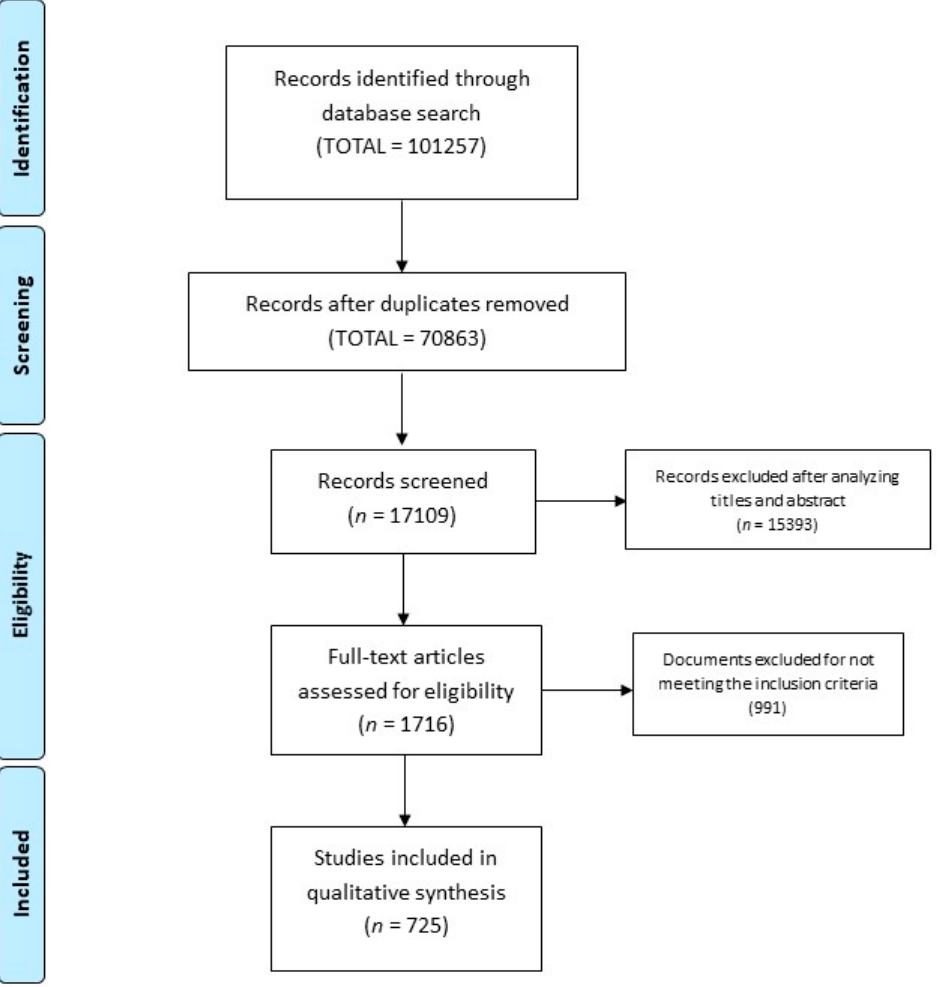
Figure 2. Study selection flow diagram.